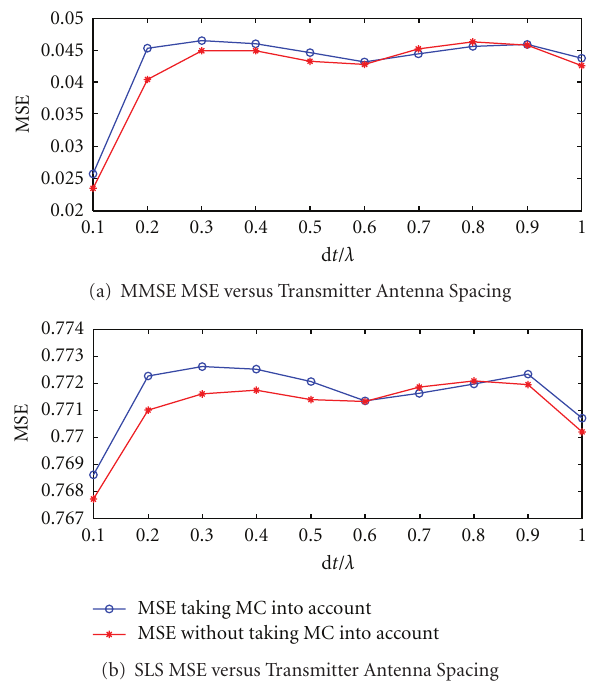
Figure 2: MMSE and SLS MSE performance versus transmitter antenna element